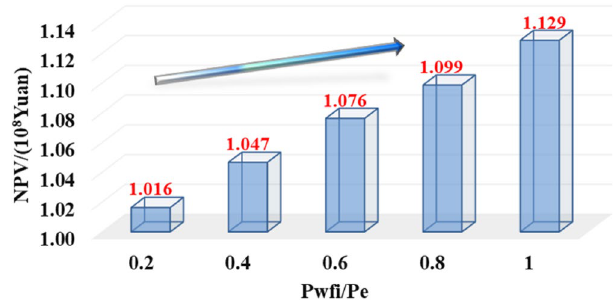
Figure 37. NPV chart of different initial controlled pressures.